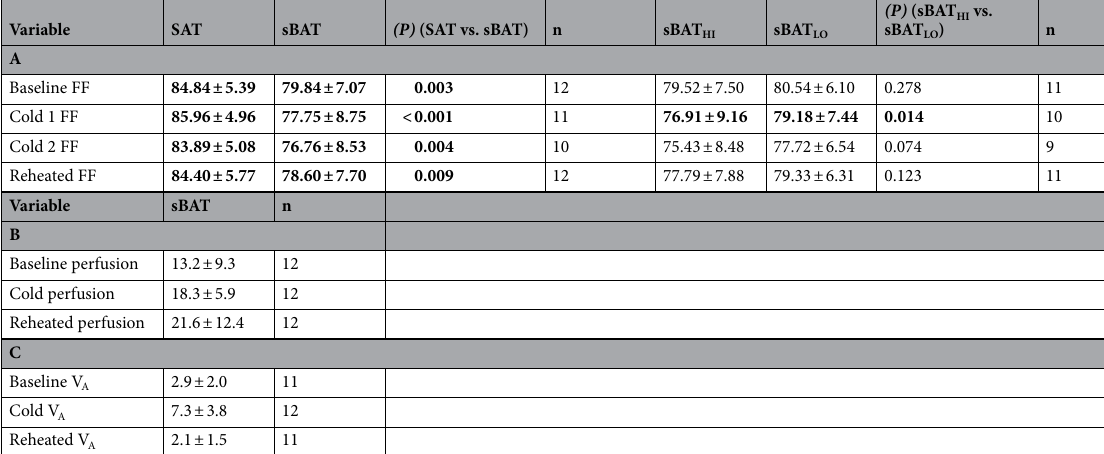
Table 1. Measurements from the Cooling-reheating protocol. (A) FF within SAT and sBAT, (B) perfusion and (C) V A in sBAT. Mean ± standard deviation. Units: FF, %; perfusion, ml/100 cm 3 /min; V A , ml/100 cm 3 . n, number of observations or number of observations included in group comparison where differences in FF between SAT and sBAT and between sBAT HI and sBAT LO were evaluated using Wilcoxon signed-rank test. Statistically significant differences ( P < 0.05) in bold